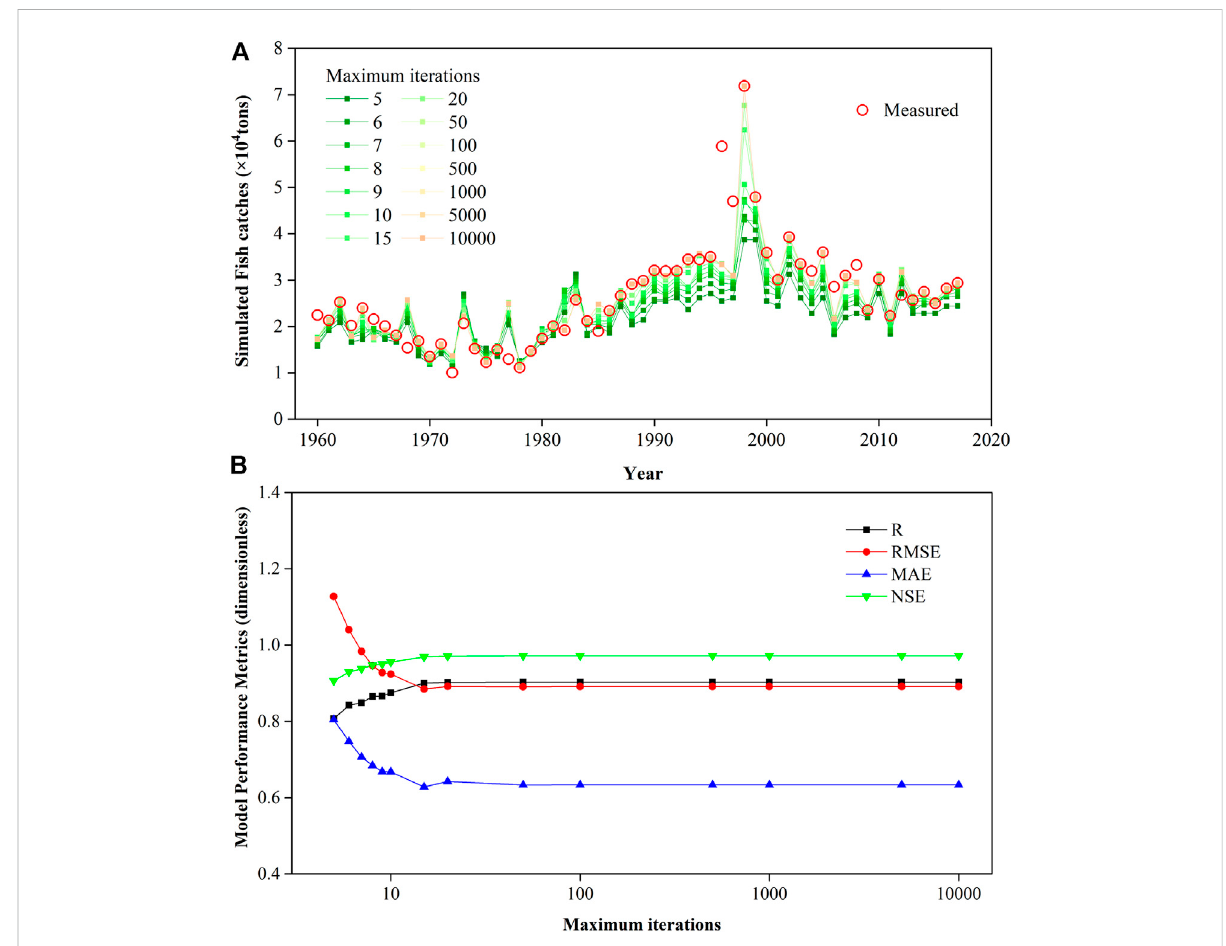
FIGURE 9 Comparison of simulations at different maximum iterations (A) and robustness test of the maximum iterations (B)